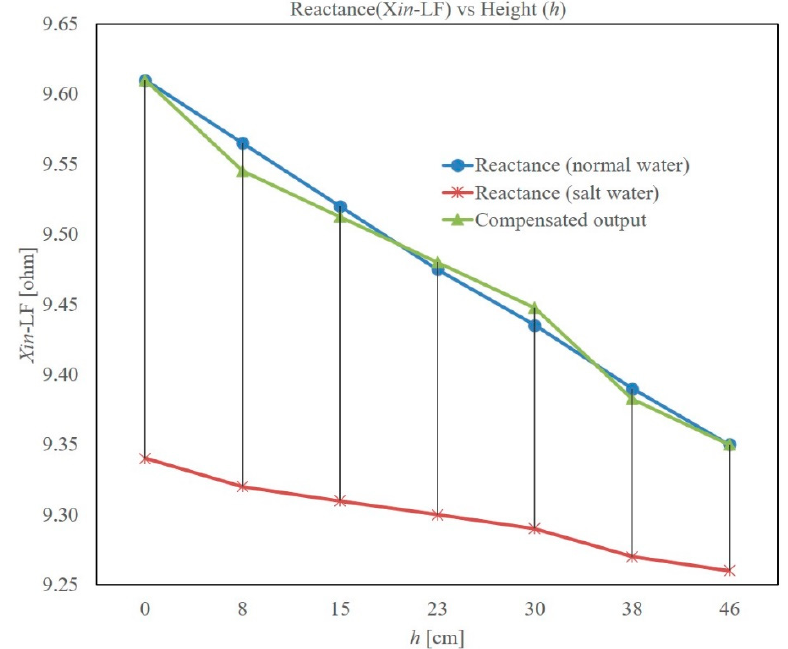
Figure 7. Effect of conductivity on the input impedance measured at 1 kHz, and compensated out- put.